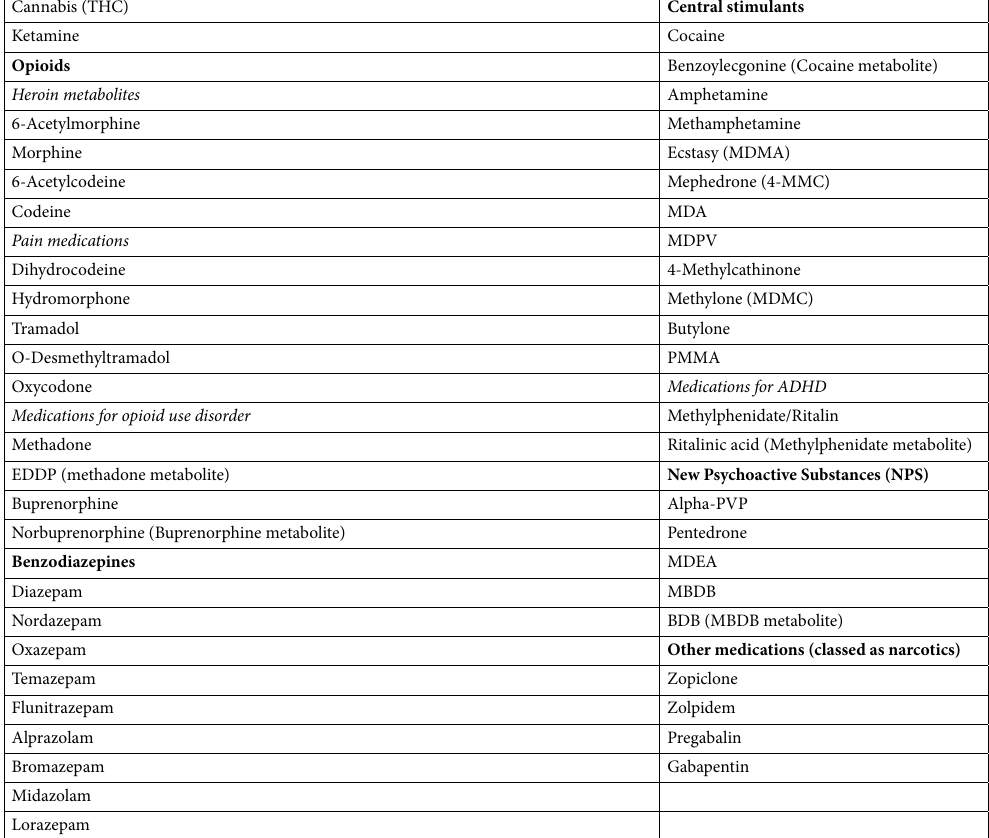
Table 4. List of substances analyzed in the breath samples. Alpha-PVP: alpha-pyrrolidinovalerophenone, BDB: 1,3-Benzodioxolylbutanamine, EDDP: 2-Ethylidene-1,5-dimethyl-3,3-diphenylpyrrolidine, MBDB: 1,3-Benzodioxolyl-N-methylbutanamine, MDA: 3,4-Methylenedioxyamphetamine, MDEA: 3,4-Methylenedioxy-N-ethylamphetamine, MDMA: 3,4-Methylenedioxymethamphetamine, MDMC:3,4- methylenedioxy- N -methylcathinone, MDPV: Methylenedioxypyrovalerone, 4-MMC: 4-methyl methcathinone, PMMA: para-Methoxyamphetamine, THC: